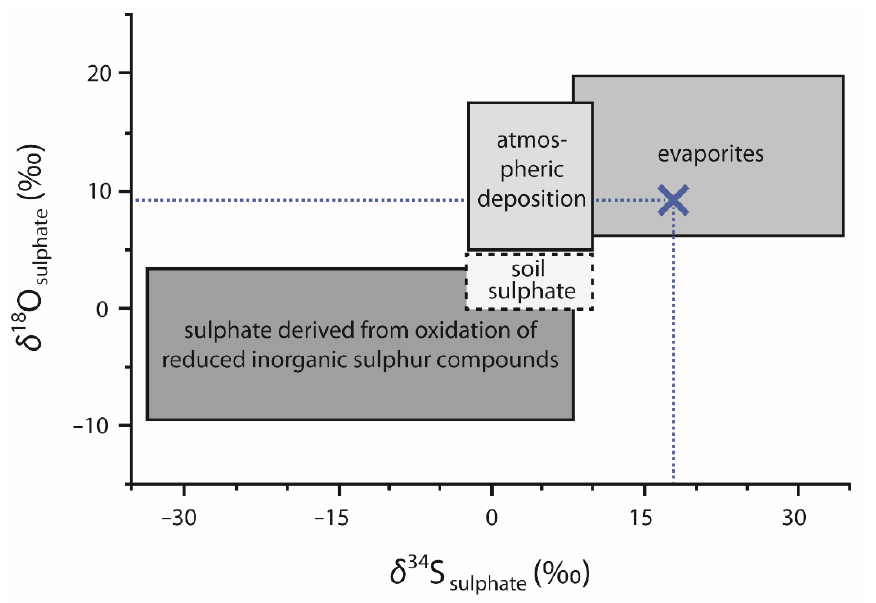
Figure 8. Values of δ 34 S SO4 and δ 18 O SO4 on the diagram with commonly observed isotopic ranges for sulphate of various origins (modified after [69]). The Žvepovnik spring is marked with a blue cross (X). Table 3. Results of microbiological analyses (date of sampling 23 July